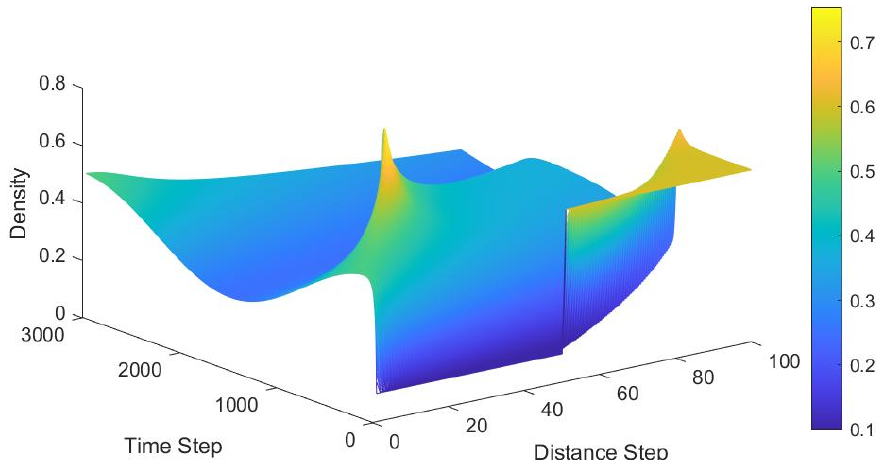
Figure 4. Density behavior of proposed model on straight road with ingress traffic.